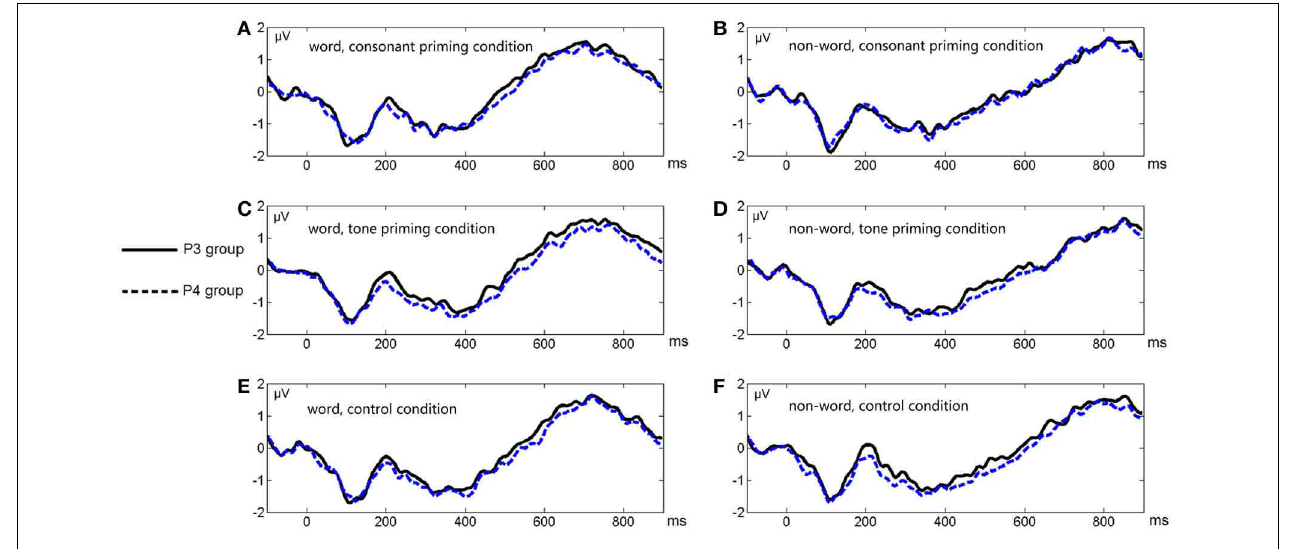
FIGURE 6 | Average ERP waveforms of the P3 and P4 electrode groups under the six conditions of Experiment 2. (A) consonant priming condition; (B) Non-word, consonant priming